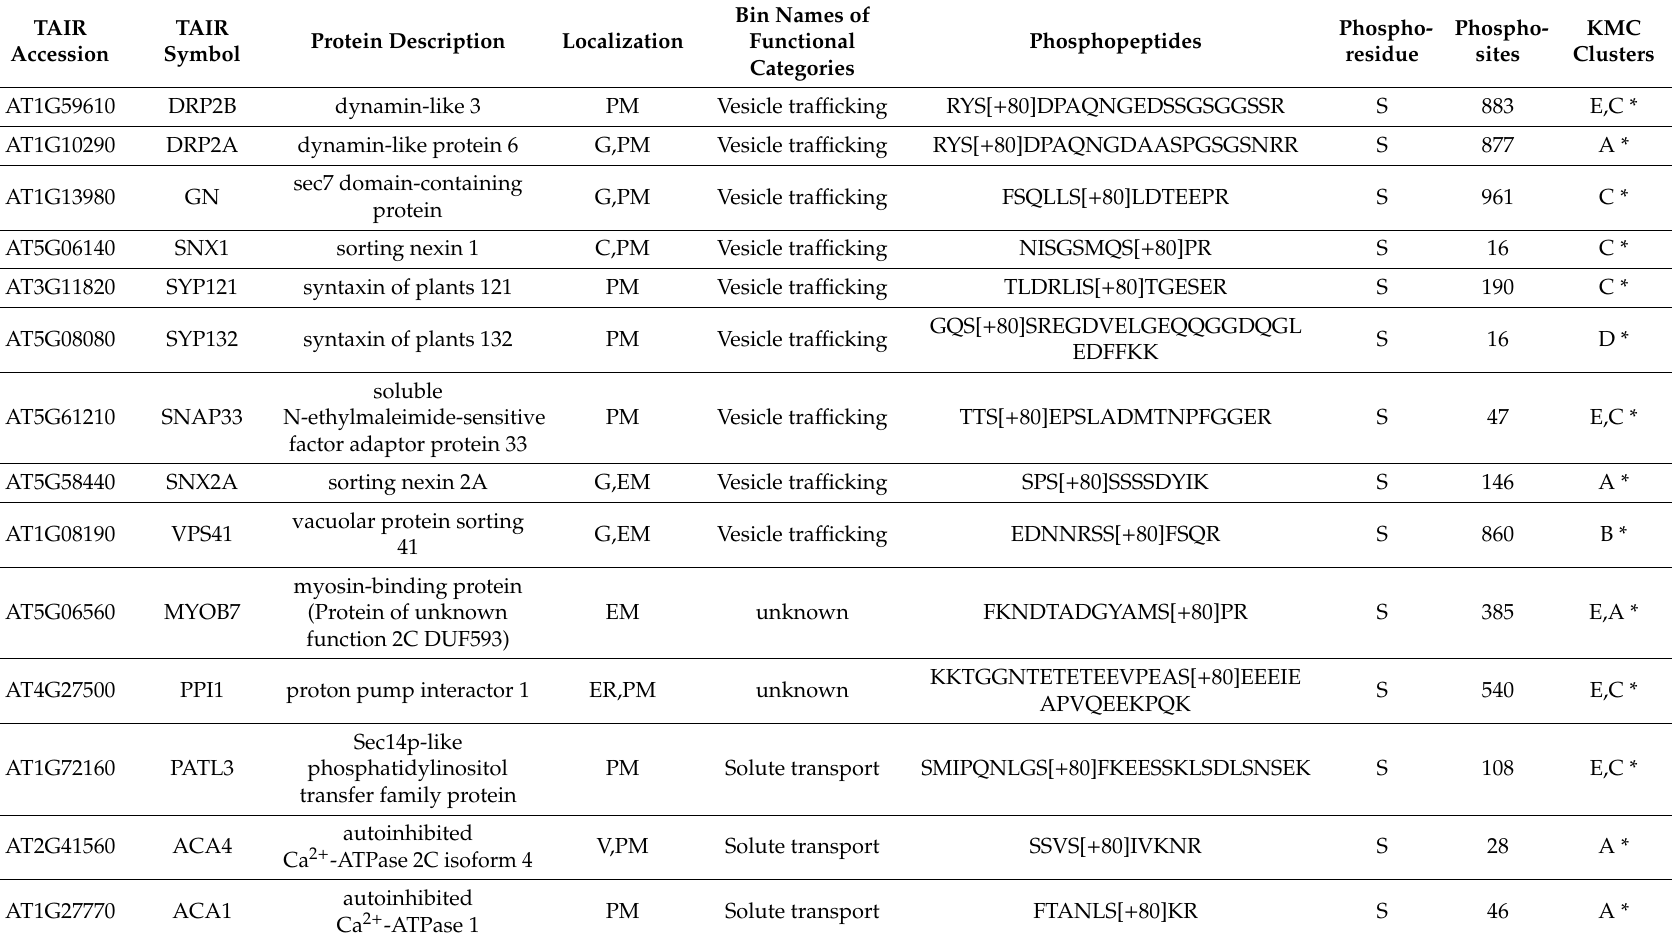
Table 1. The phosphopeptides described in the Results and Discussion